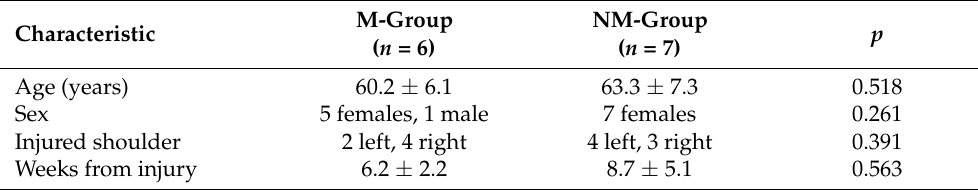
Table 1. Patient characteristics of the non-manipulated feedback treatment group (NM-group) and the manipulated feedback treatment group